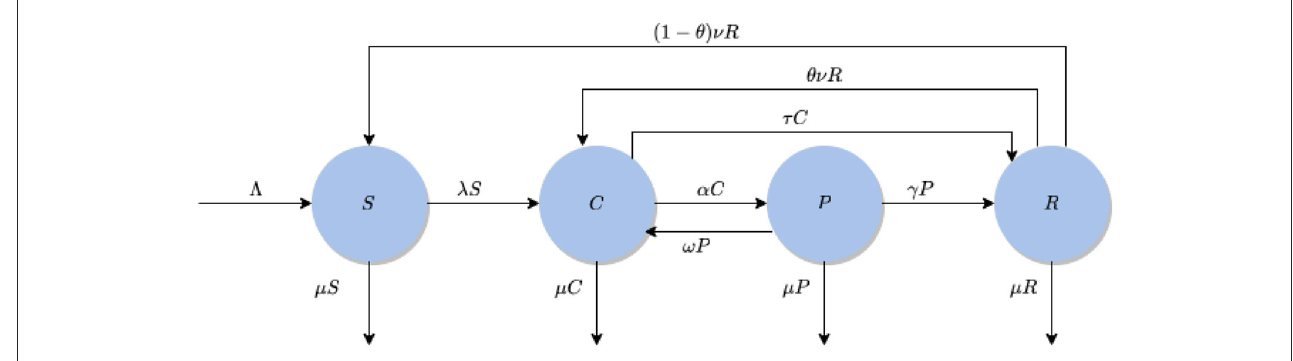
FIGURE1 Flow diagram of the model (Equations 1–4).